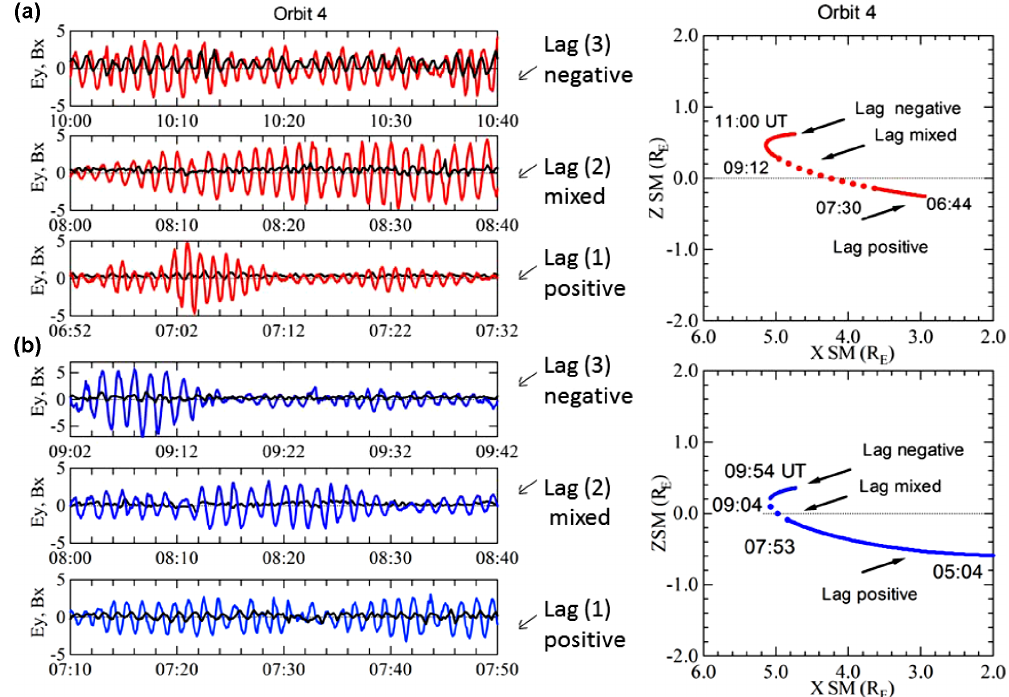
Figure 7. Phase relations between B x (plotted in red and blue) and E y (plotted in black) on Orbit 4 of Van Allen Probes A and B, during 1, 2 and 3 intervals (left panel). Locations of the spacecraft relative to the equator (right panel). During the first (third) intervals, E y lags (leads) B x by 90 ◦ when the spacecraft were south (north) of the equator, in agreement with what is expected for second-harmonic waves. Observations during the second intervals when the spacecraft crossed the equator indicate mixed-phase relationships and double-frequency pulsations in E y . E y and B x are displayed in mVm − 1 and nT, respectively.